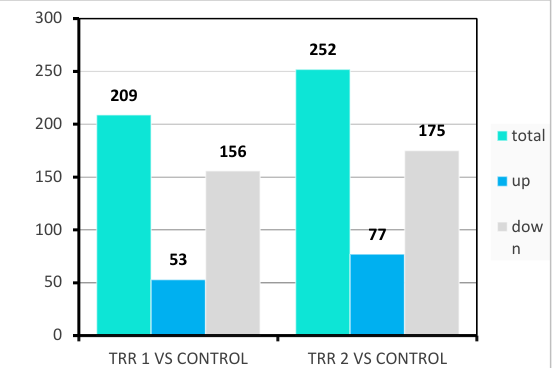
Figure 3. Differentially expressed genes in ammonia (treatment 1) and stocking density (treatment 2) compared to the controls. The threshold for a gene to be considered differentially expressed was DESeq2 padj ≤ 0.05 and |log2FoldChange| ≥ 1.0.